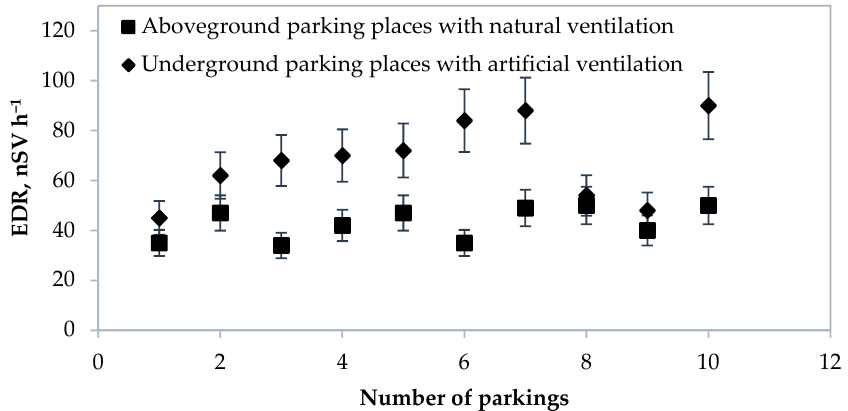
Figure 2. Equivalent dose rate (EDR) in different types of parking lots.